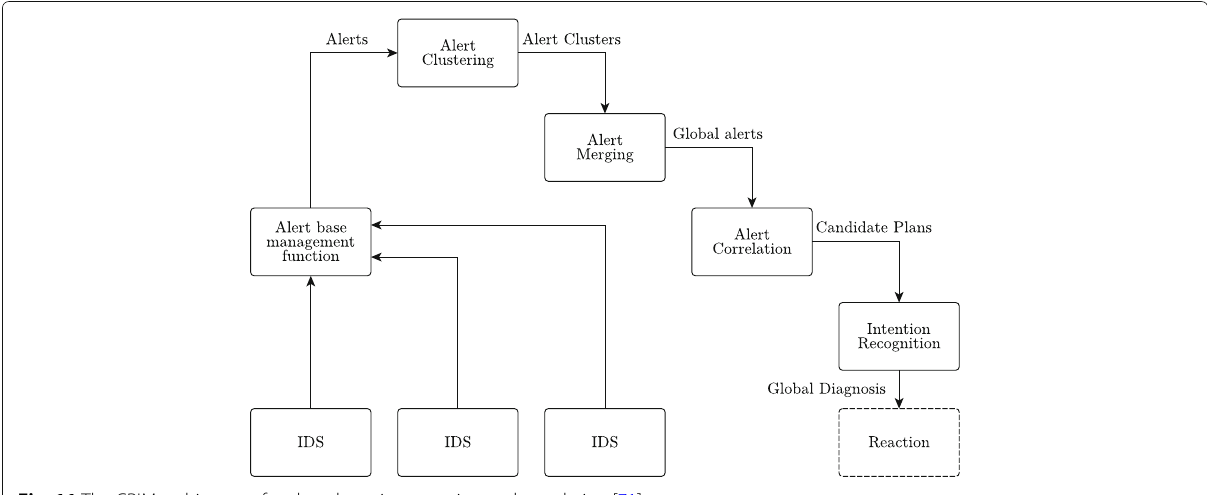
Fig. 11 The CRIM architecture for alert clustering, merging and correlation [71]